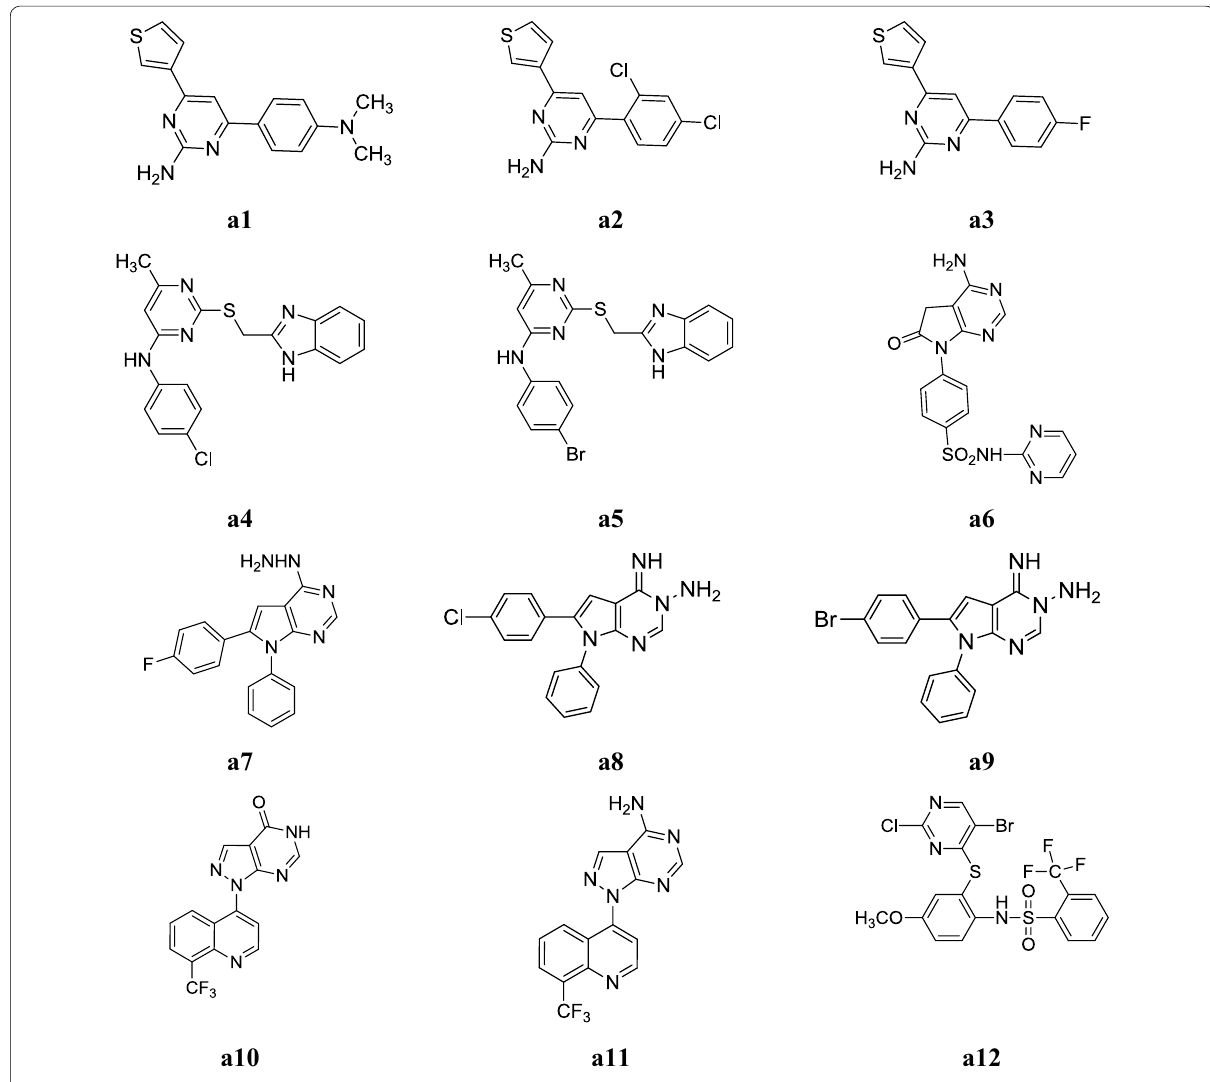
Fig. 2 Chemical structure of the most active antimicrobial pyrimidine derivatives ( a1 – a12 )